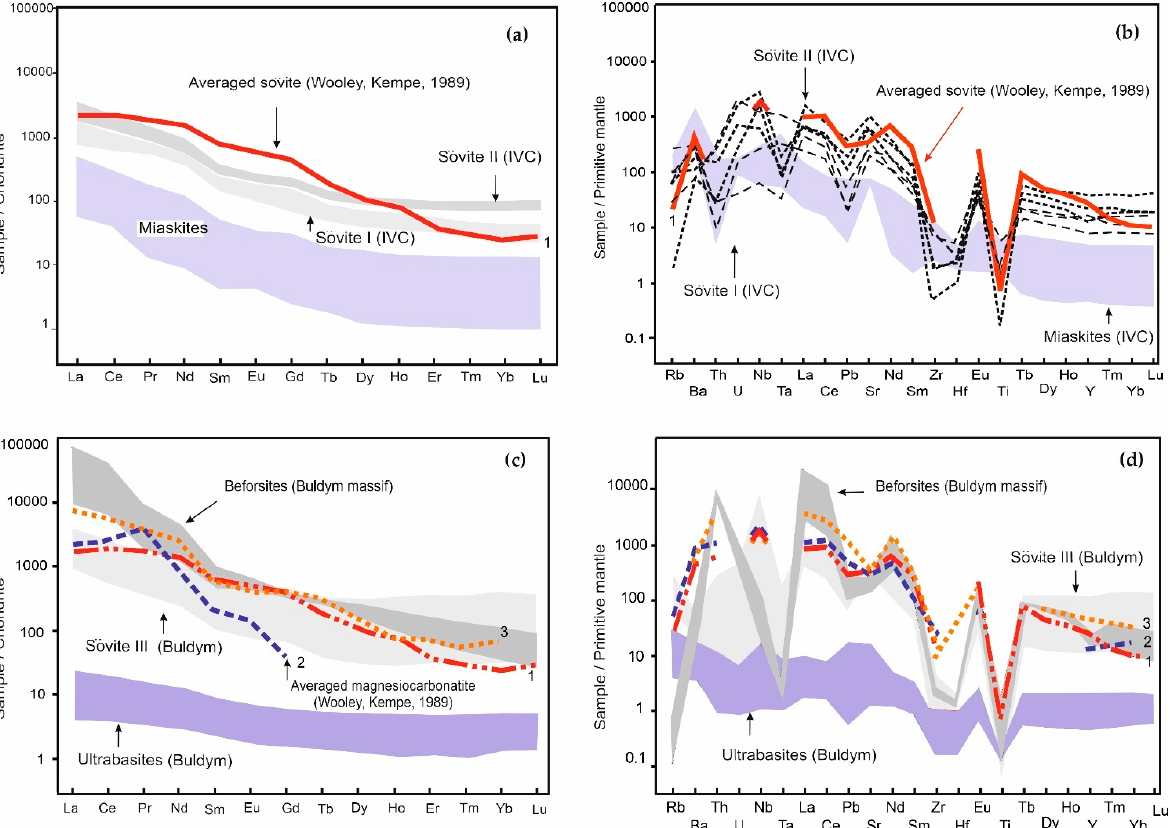
Figure 6. Chondrite-normalized REE patterns and spider-diagrams for the main rock types of the Ilmeno–Vishnevogorsk ( a , b ) and Buldym ( c , d ) complexes, South Urals. For comparison, average composition for calciocarbonatite (1), magnesiocarbonatite (2), and ferrocarbonatite (3), according to [101] are presented.